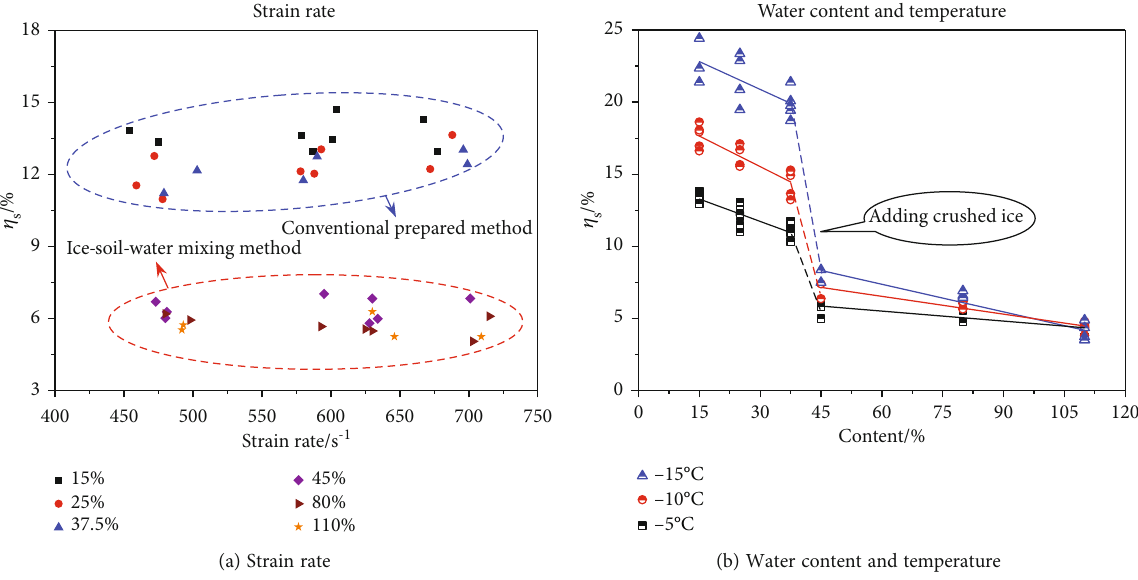
Figure 7: The absorption energy rate of frozen sandy soil with various